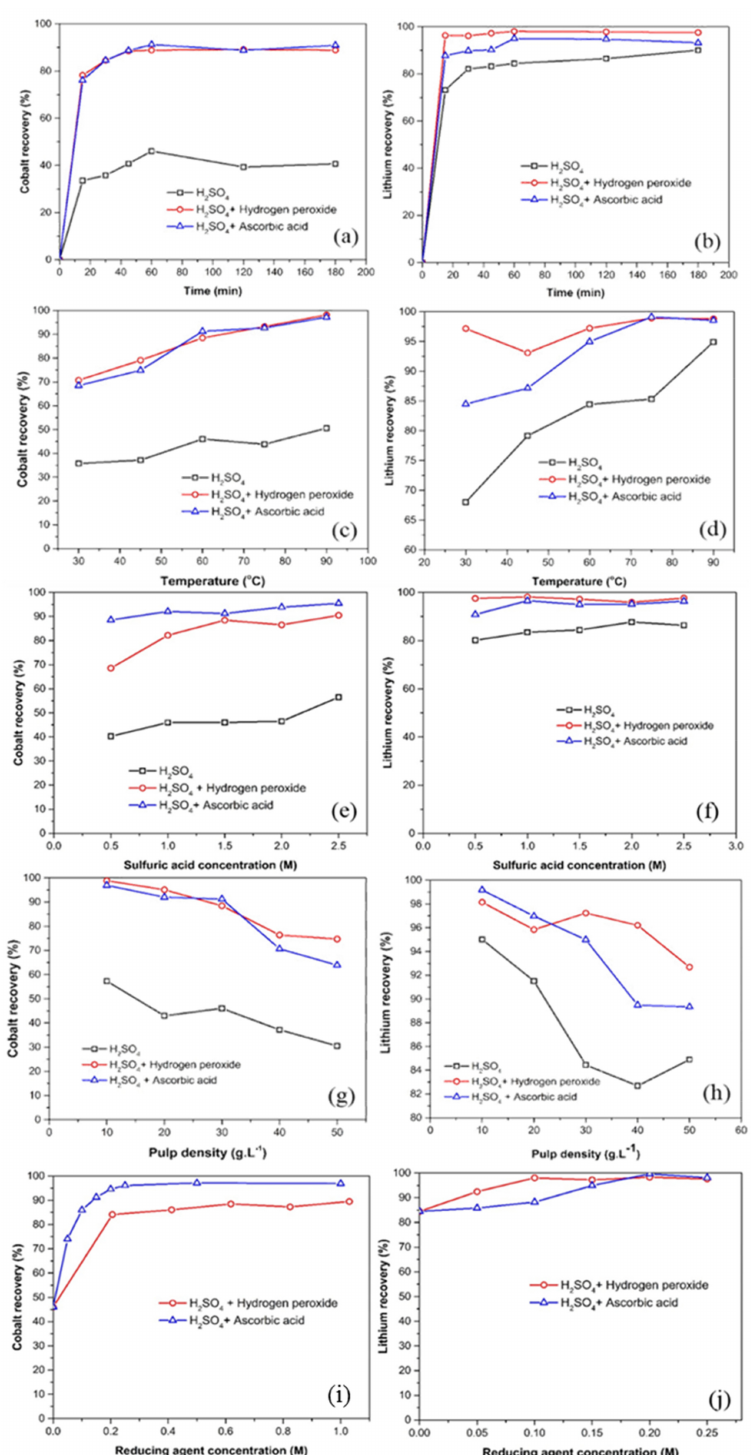
Figure 2. Effect of different parameters on Co and Li recovery by changing one parameter while keeping the other parameters constant at the center level. ( a , b ) Effect of time, T = 65 ◦ C, H 2 SO 4 = 1.5 M, C 6 H 8 O 6 = 0.15 M, H 2 O 2 = 0.636 M, and S/L = 30 g/L ( c , d ) Effect of temperature, Time = 60 min, H 2 SO 4 = 1.5 M, C 6 H 8 O 6 = 0.15 M, H 2 O 2 = 0.636 M, S/L = 30 g/L ( e , f ) Effect of sulfuric acid concentration, Time = 60 min, T = 65 ◦ C, C 6 H 8 O 6 = 0.15 M, H 2 O 2 = 0.636 M, S/L =30 g/L ( g , h ) Effect of pulp density, Time = 60 min, T = 65 ◦ C, C 6 H 8 O 6 = 0.15 M, H 2 O 2 = 0.636 M, H 2 SO 4 = 1.5 M ( i , j ) Effect of reducing agent concentration, Time = 60 min, T = 65 ◦ C, H 2 SO 4 = 1.5 M, S/L = 30